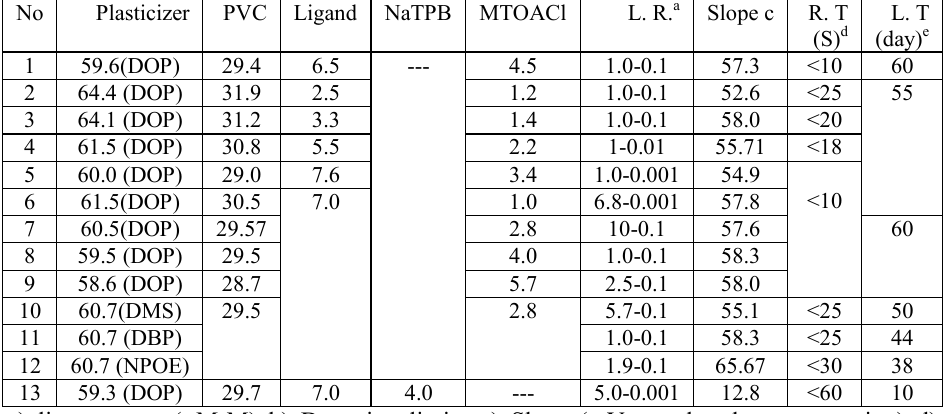
Table 1. Response Performance of the iodide ion-selective electrode, conditions: various membrane composition, conditioned 24 h in 0.05 M KI.